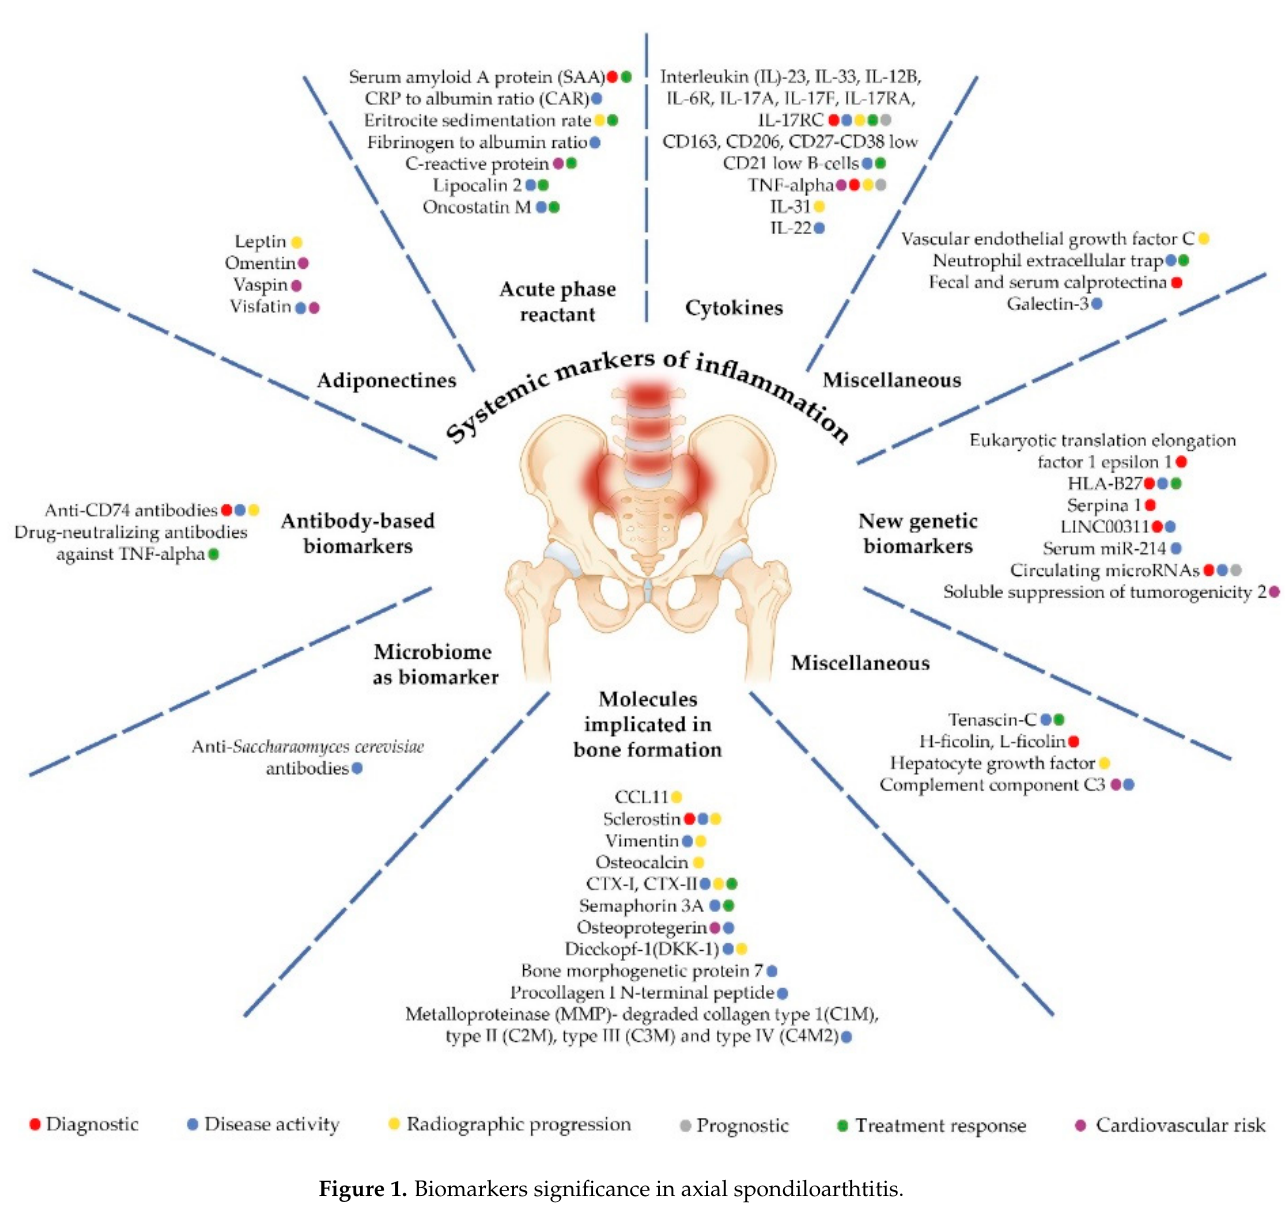
Figure 1. Biomarkers significance in axial spondiloarthtitis.